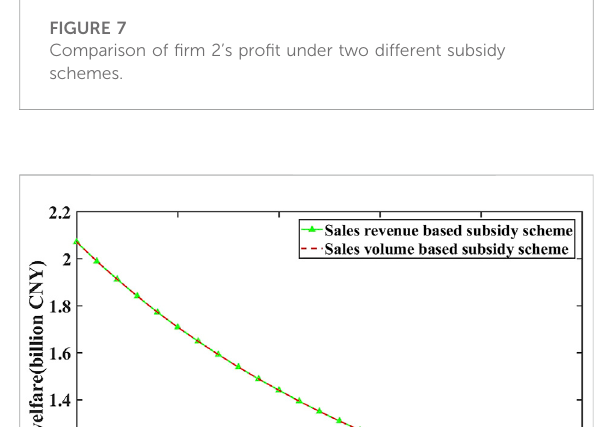
FIGURE 5 Comparisonof fi rm2 ’